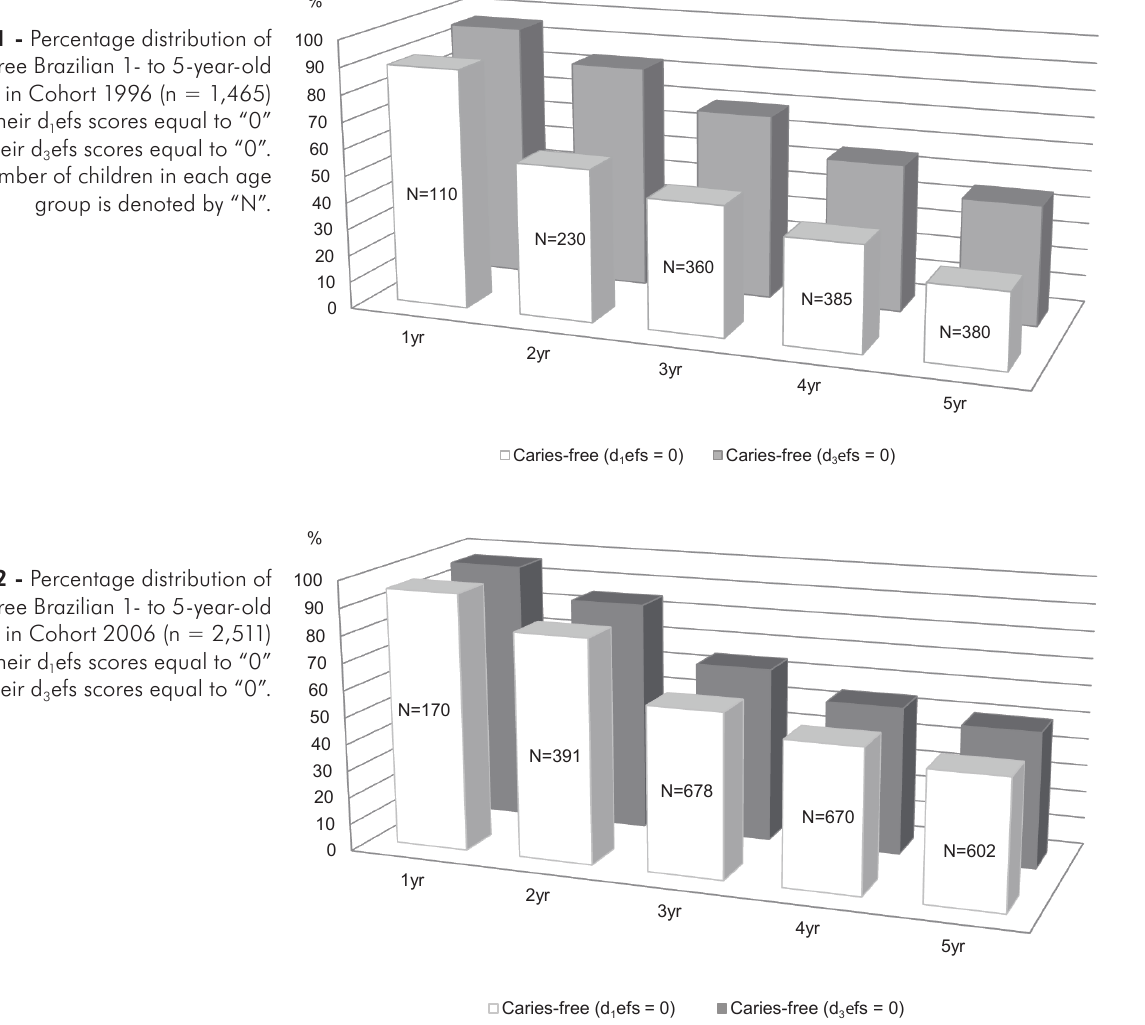
Figure 1 - Percentage distribution of caries-free Brazilian 1- to 5-year-old children in Cohort 1996 (n = 1,465) with their d efs scores equal to “0” 1 and their d efs scores equal to “0”. 3 group is denoted by